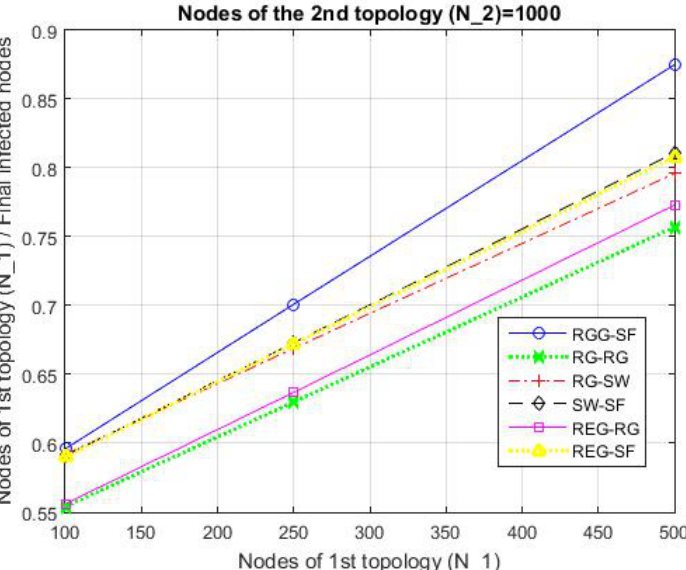
Figure 15. Spread of malware while the nodes of the 2nd topology remain equal to N_1 =